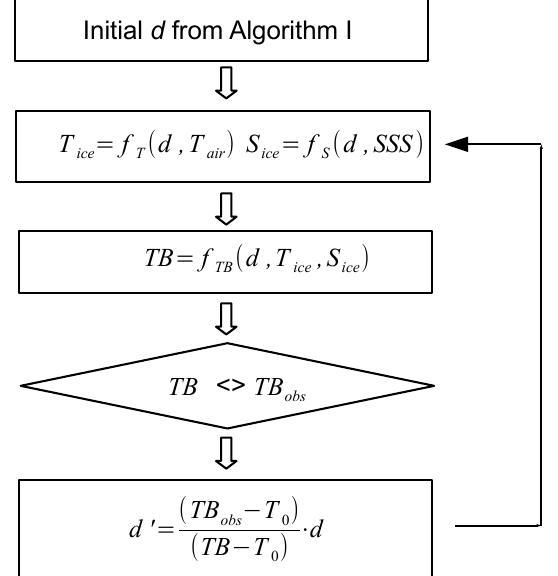
Figure 7. Schematic flow chart of the retrieval steps. d and d 0 are the sea ice thicknesses from the consecutive steps, TB and TB obs are calculated and observed brightness temperatures, and T 0 is the brightness temperature of sea water assumed to be 100.5K.